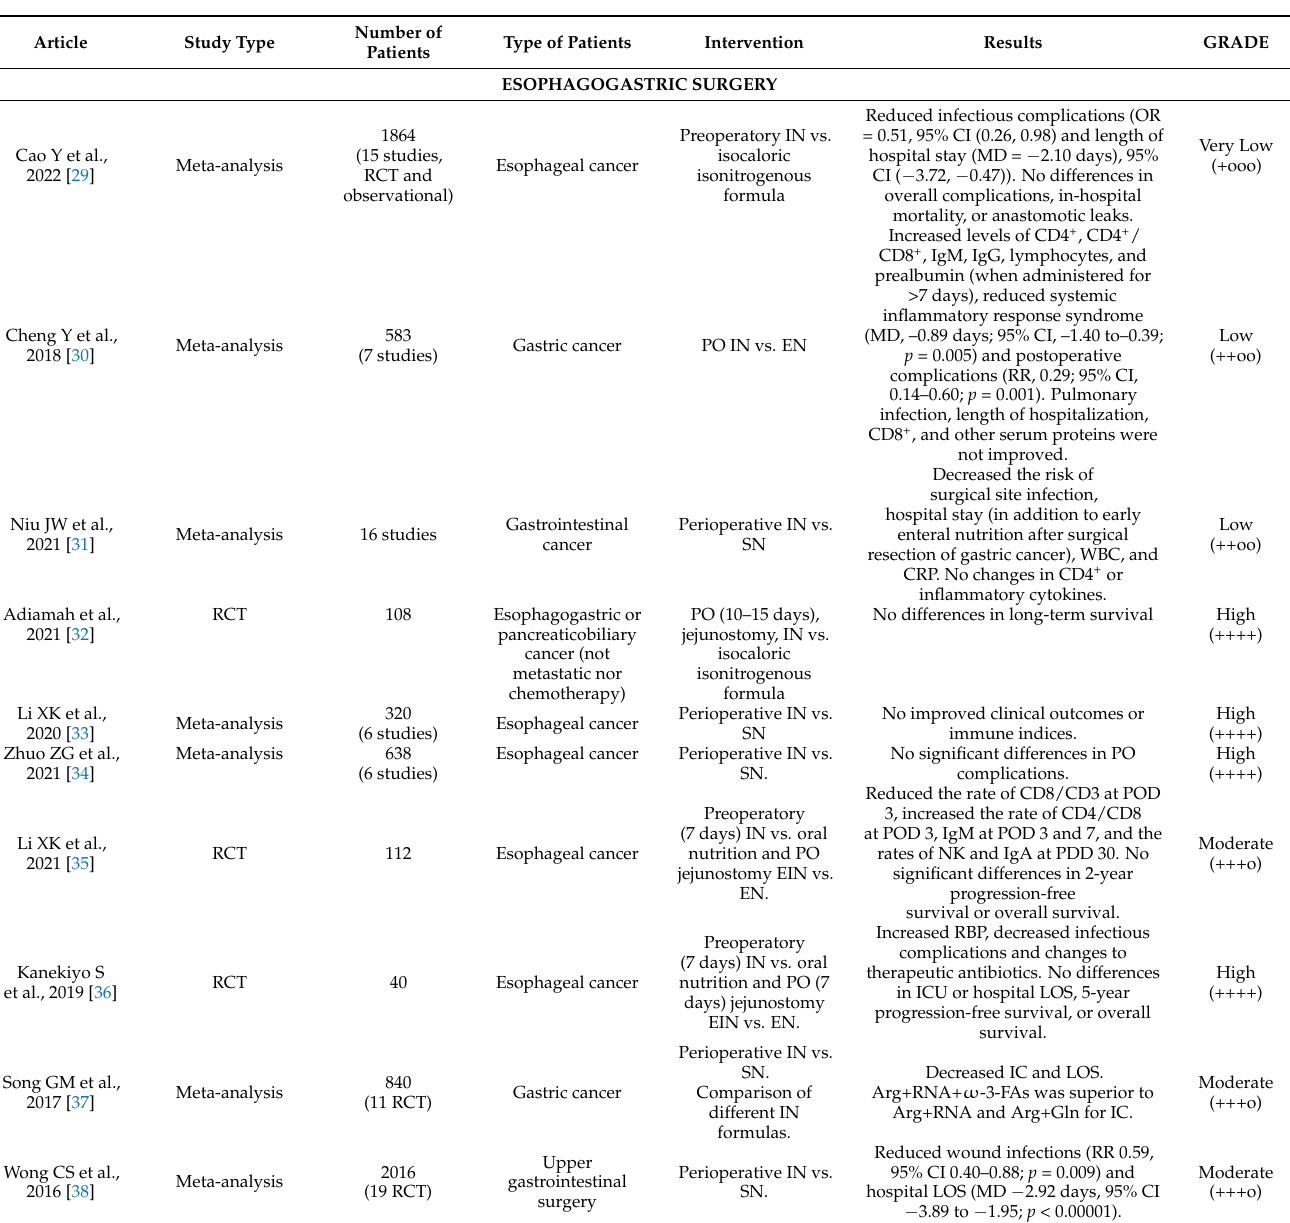
Table 7. Summary of the evidence obtained based on the search strategy and selection of articles with evidence rating using GRADEpro for esophagogastric surgery. IN: immunonutrition; SN: standard nutrition; ONS: oral nutrition supplement; PO: postoperative, UTI: urinary tract infection; LOS: length of